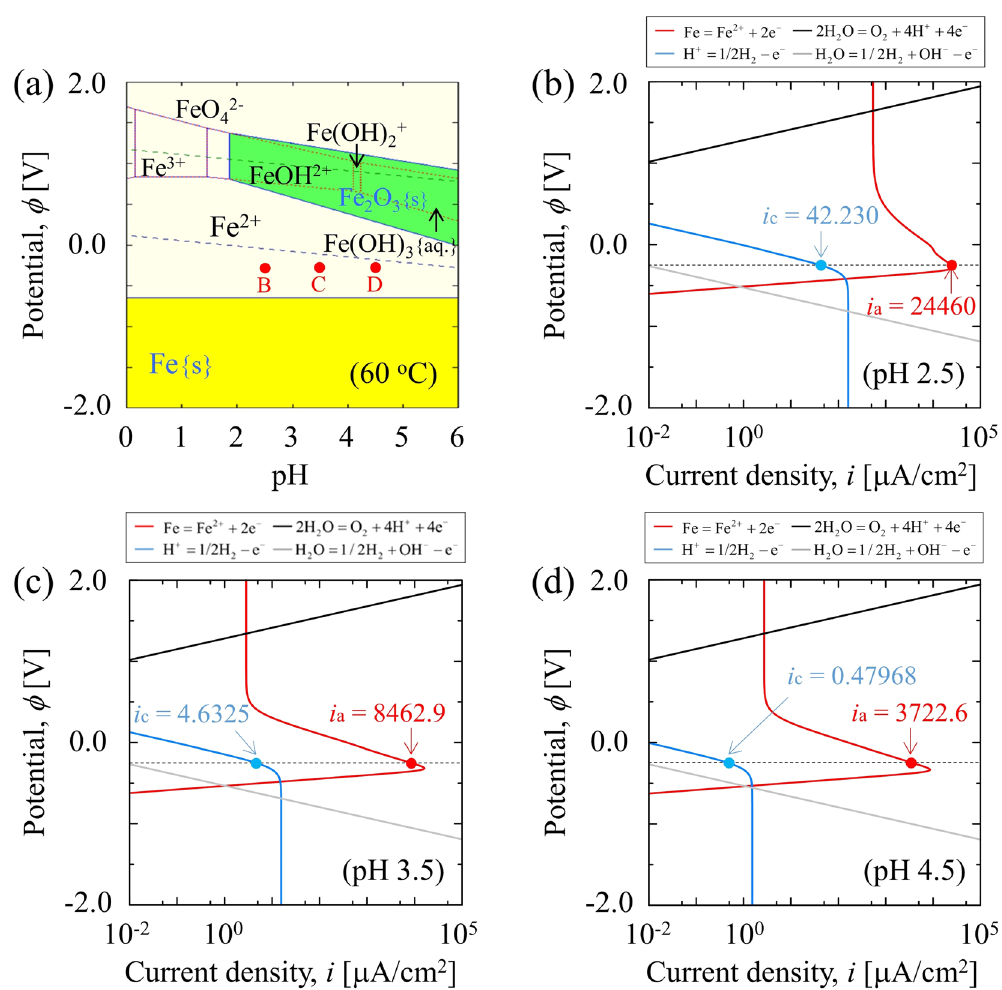
Figure 1. ( a ) Pourbaix diagram at 60 °C and polarization curves at the pH of ( b ) 2.5, ( c ) 3.5, and ( d ) 4.5 as calculated by Corrosion Analyzer software. ( b , c ), and ( d ) show the polarization curves at each pH indicated by B, C, and D in ( a ), respectively. The anodic and cathodic current densities, i.e., i a and i c , are inserted on the polarization